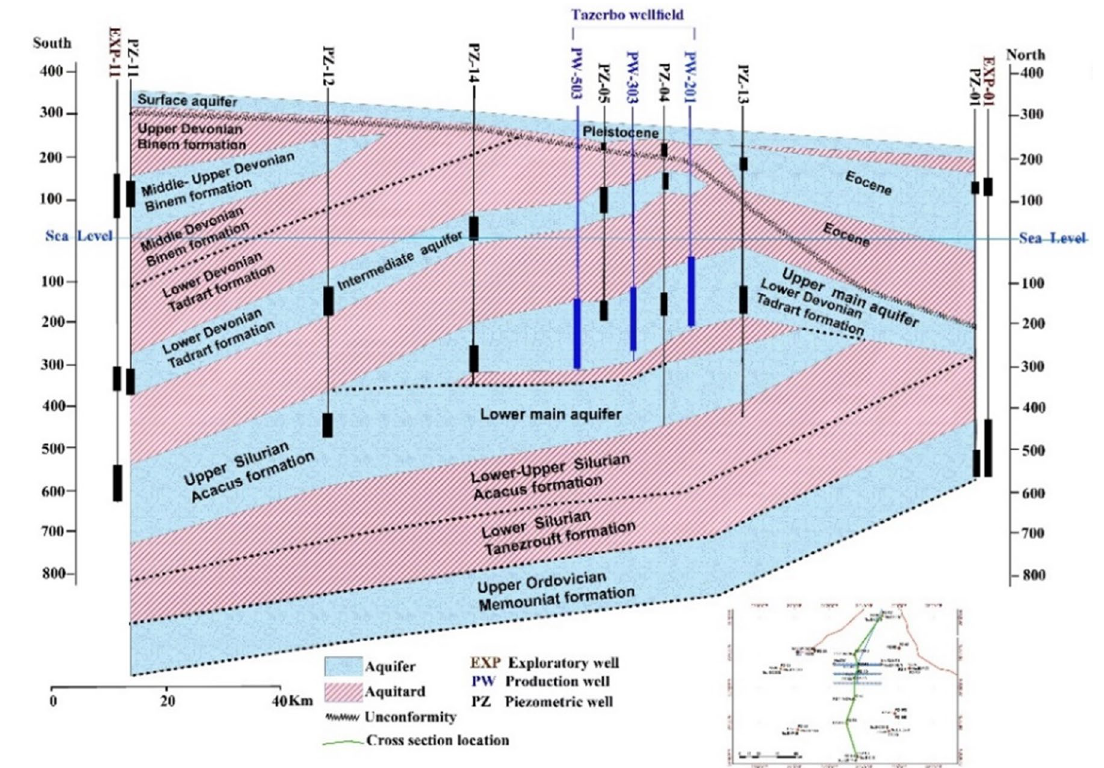
Fig. 3 Regional North–South the geological cross section, modified after (TCGM